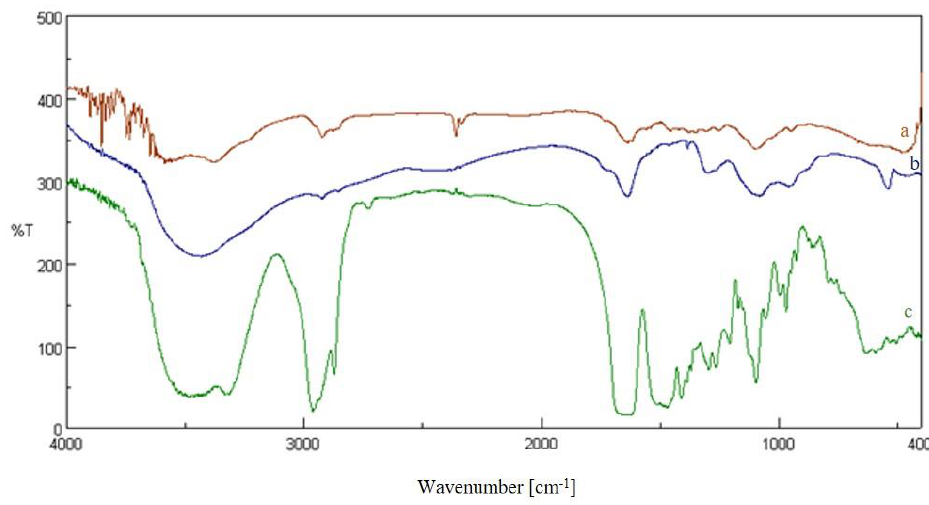
Figure 2. FT-IR of CsACC ( a ), CC ( b ), CsA ( c ).